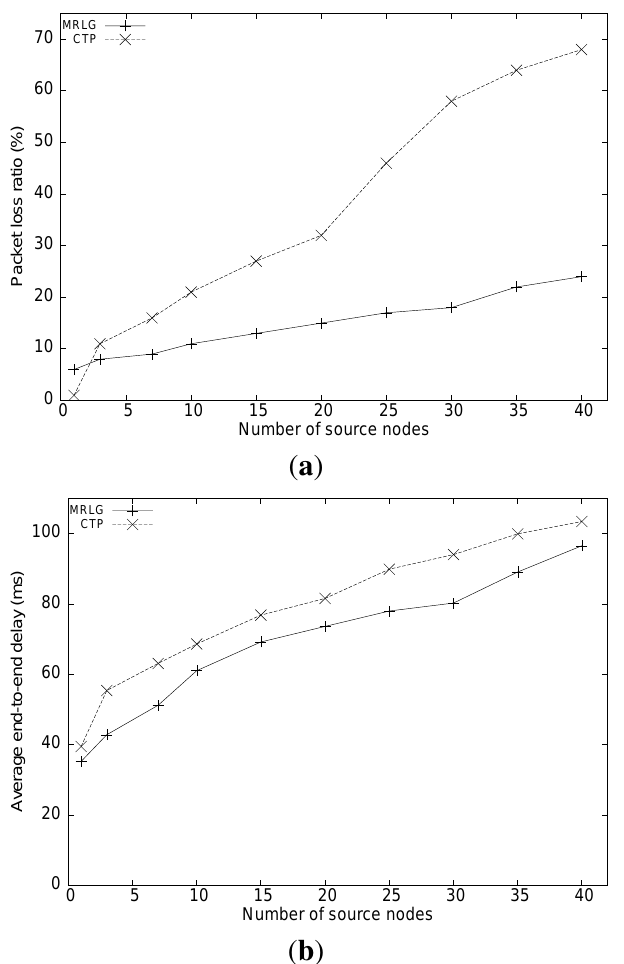
Figure 5. Varying the number of source nodes: ( a ) packet loss ratio, ( b ) end-to-end